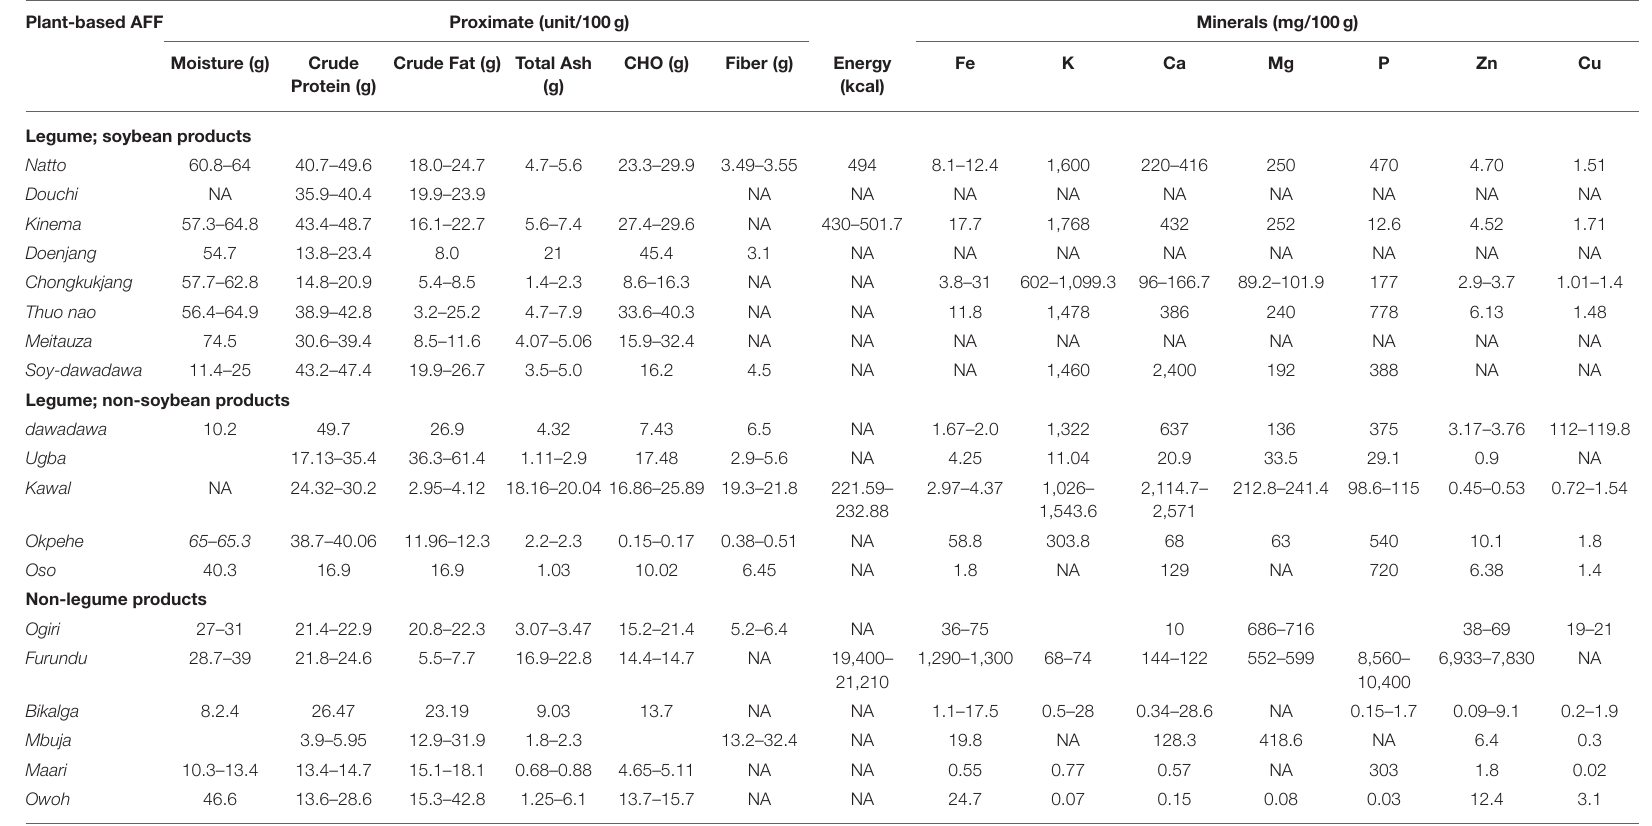
TABLE 2 | Summarized nutritional information previously reported for some AFFs. Plant-based AFF Proximate